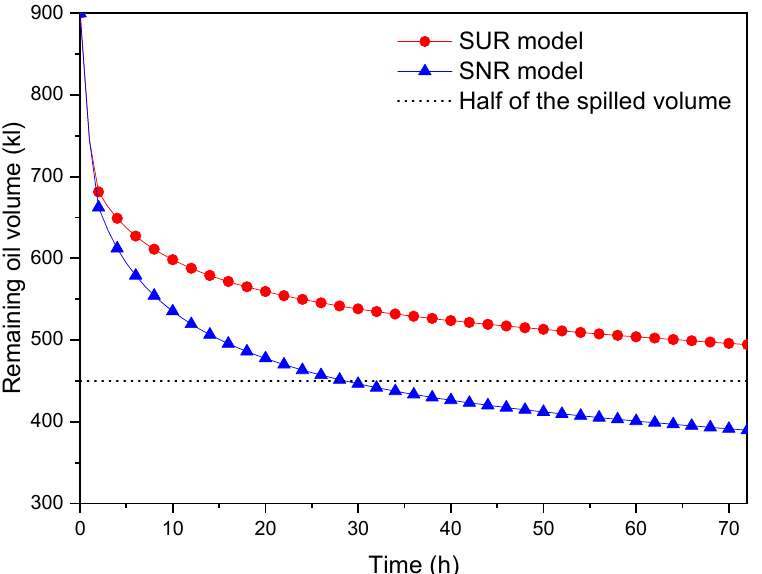
Figure 12. Comparison of the remaining oil volume of the SUR model and the SNR model (for 900 kl spill case).